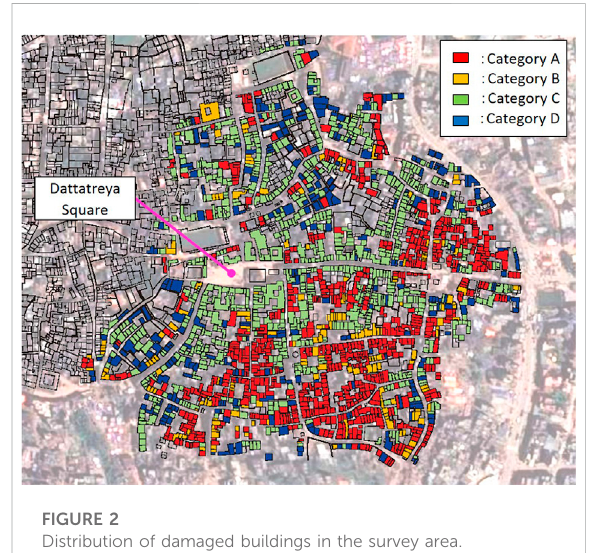
FIGURE 2 Distribution of damaged buildings in the survey